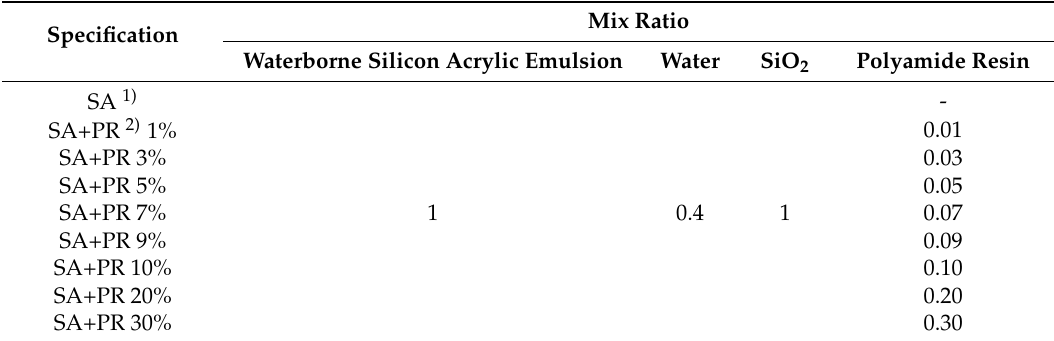
Table 8. Mix design of silicon acrylic with polyamide.